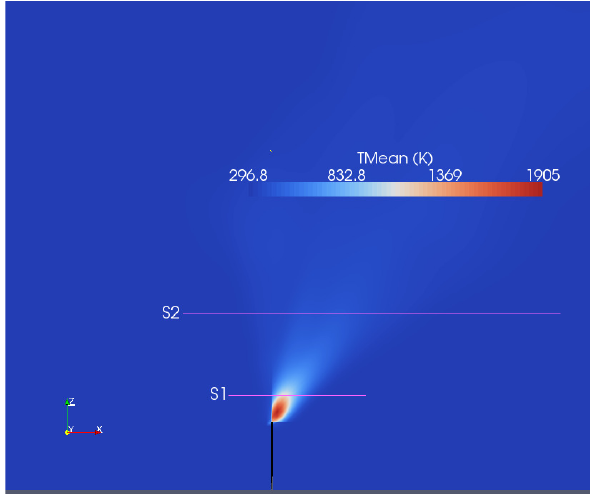
Figure 2. Average temperature field for the sour gas flare. The location of the slices is in 2 Fig. 2. Average temperature field for the sour gas flare. The location Magenta 3 of the slices is in